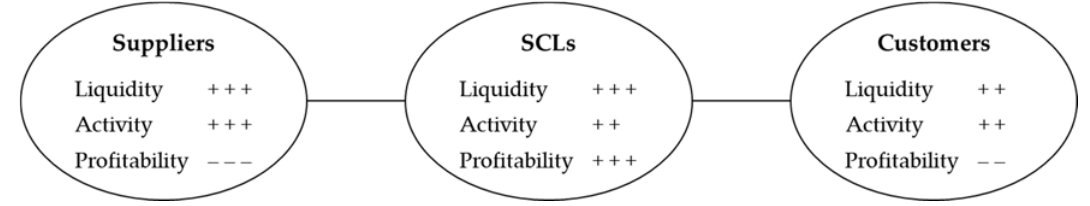
Figure 4. Financial performance distribution in the SCL networks. +++ very strong positive correlation; ++ strong positive correlation;. – – – very strong negative correlation; – – strong negative correlation.